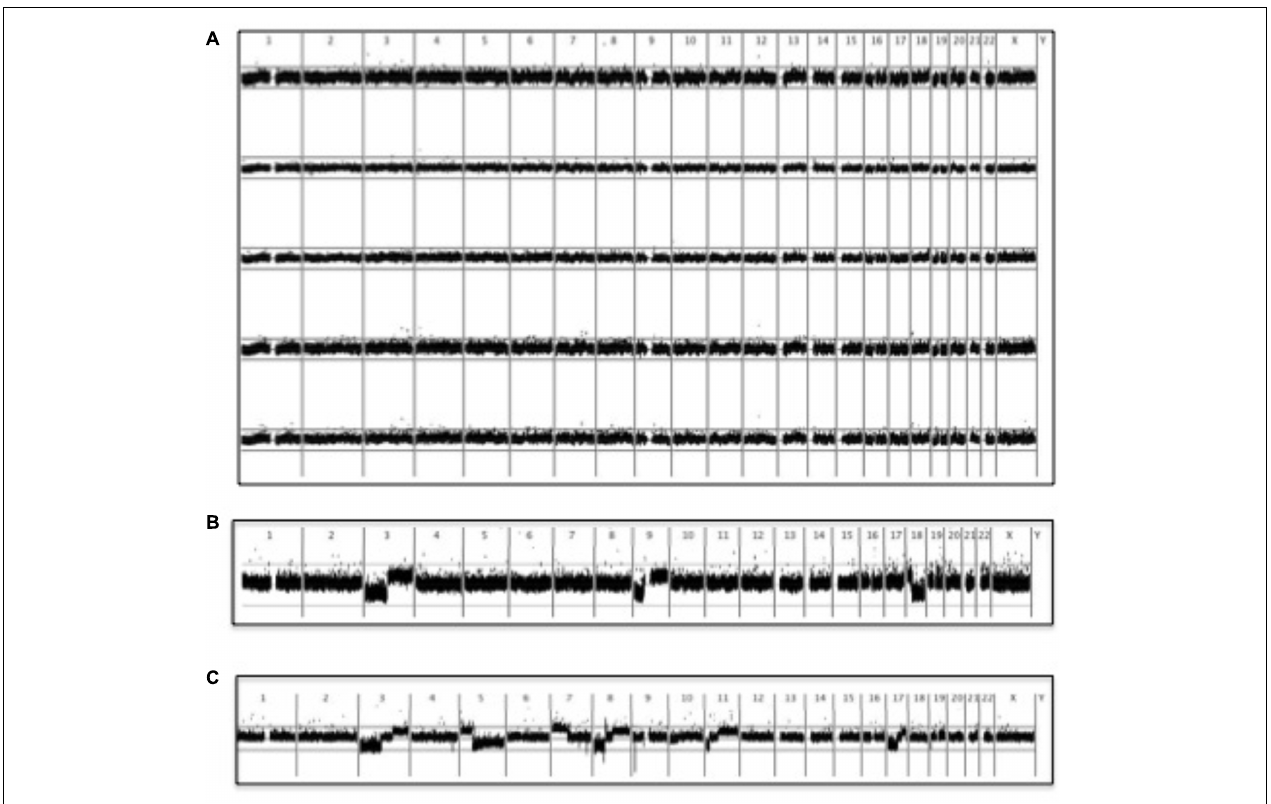
FIGURE 5 | SNP microarray analysis of vemurafenib-associated cSCC. BRAFi-SCC did not display the gross chromosomal aberrations typically observed in sporadic cSCC (Purdie et al., 2009). A running average of 2 consecutive tumor: non-tumor signal value ratios is plotted on a log2 scale according to chromosomal position. Upper line represents log2(2) and lower represents log2(0.5). (A) Copy number profiles of 5 vemurafenib-associated cSCC (B) Comparison with copy number profile from a sporadic cSCC showing 3p and 9p loss: these changes were characteristic of well-differentiated cSCC (Purdie et al., 2009). Although chromosome 18 loss is also seen in this particular tumor, chromosome 18 aberrations were not as common as 3p and 9p changes in other sporadic well-differentiated cSCC (Purdie et al., 2009). (C) More extensive allelic imbalance in a sporadic moderately-differentiated cSCC (Purdie et al.,